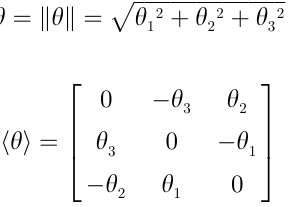
ffiffiffiffiffiffiffiffiffiffiffiffiffiffiffiffiffiffiffiffiffiffiffiffiffiffiffiffiffi y 12 þ y 22 þ y 32